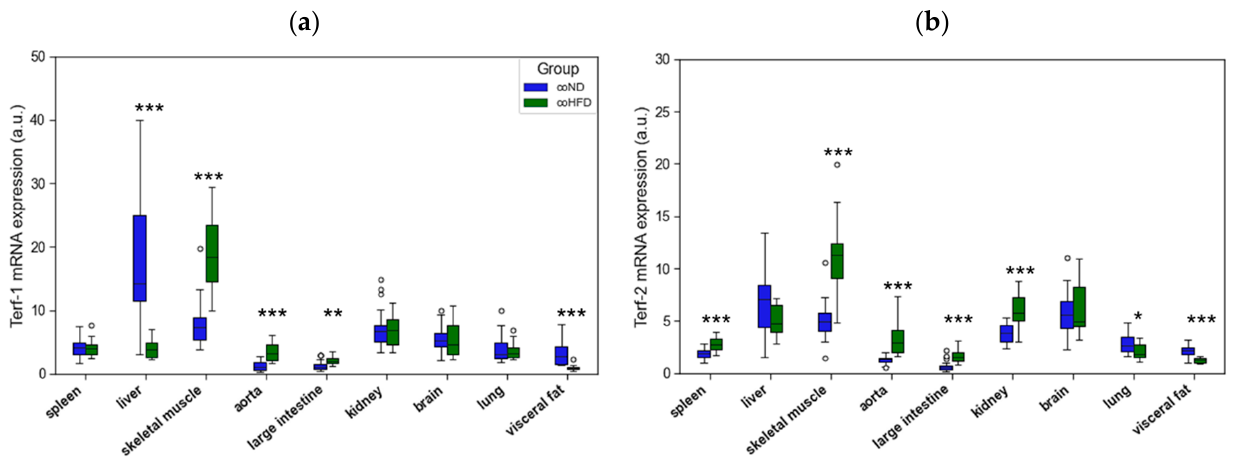
Figure 4. Differences in the gene expression of ( a ) TERF-1, and ( b ) TERF-2 isolated from different solid organs of lean (coND) and obese rats (coHFD). Outliers are shown as white circles above the box plots. TERF-1, and TERF-2 mRNA expression is shown in arbitrary units. The two-tailed Student’s t -test or the Mann–Whitney U-test were used for group comparison of independent samples. * p < 0.05; ** p < 0.01; *** p < 0.001 vs. conD.